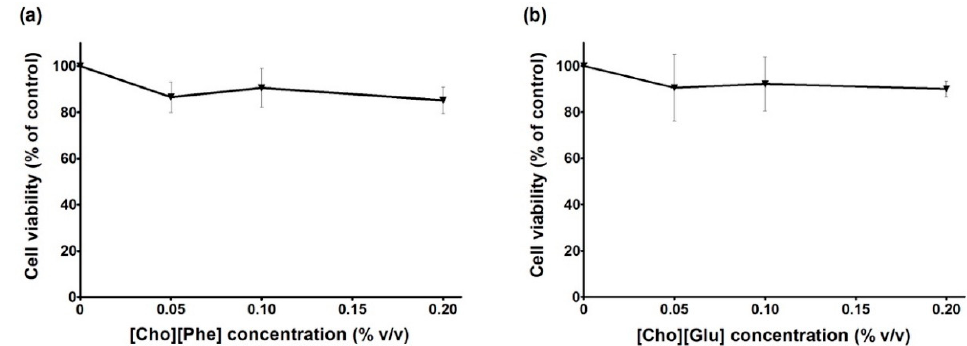
Figure 2. Cell viability of MDA-MB-231 cells exposed to choline-based ILs (0–0.2%, v/v ), [Cho][Phe] ( a ) and [Cho][Glu] ( b ). The cell viability of ILs-exposed cells (48 h) was evaluated by CV assay. Values represent mean ± SD (n = 6–8) and are expressed as percentages of the non-treated control cells.